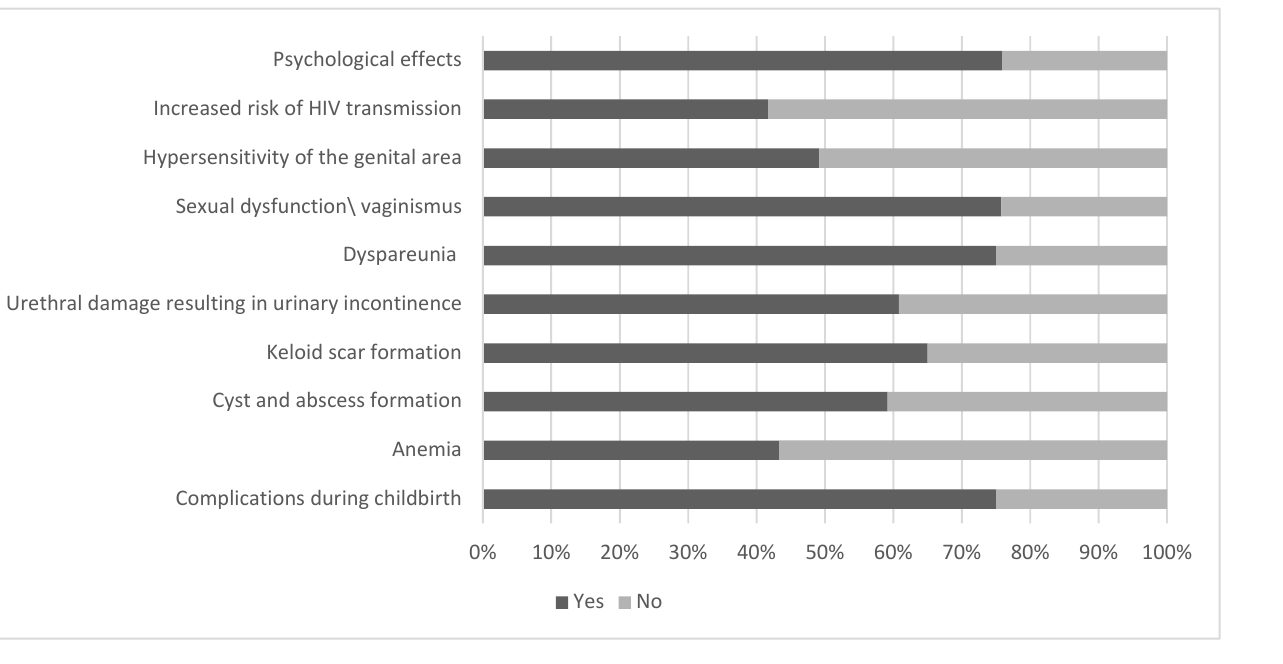
Figure 2. Participants’ knowledge about possible long-term complications caused by FGM in percetages ( n = 120).